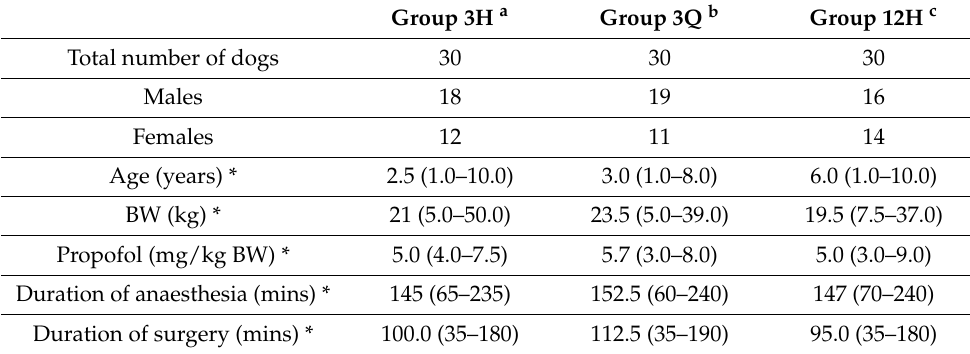
Table 1. Descriptive statistics of gender, age, body weight (BW), propofol dosage, duration of anaesthesia and surgery of the thirty dogs in each study group.